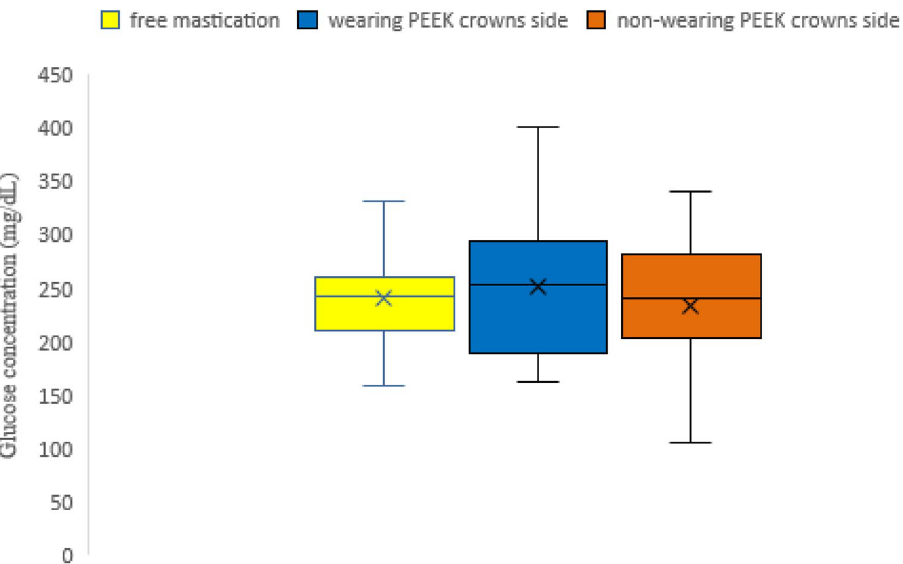
Figure 6. Boxplot of Glucose concentration by masticatory ability test in wearing PEEK side and non-wearing PEEK side. Box; inter quartile range (IQR), Lower whisker; minimum, upper whisker; maximum, Center line; median, cross mark; mean. *Mann–Whitney U test shows no significant difference between PEEK and non- PEEK wearing